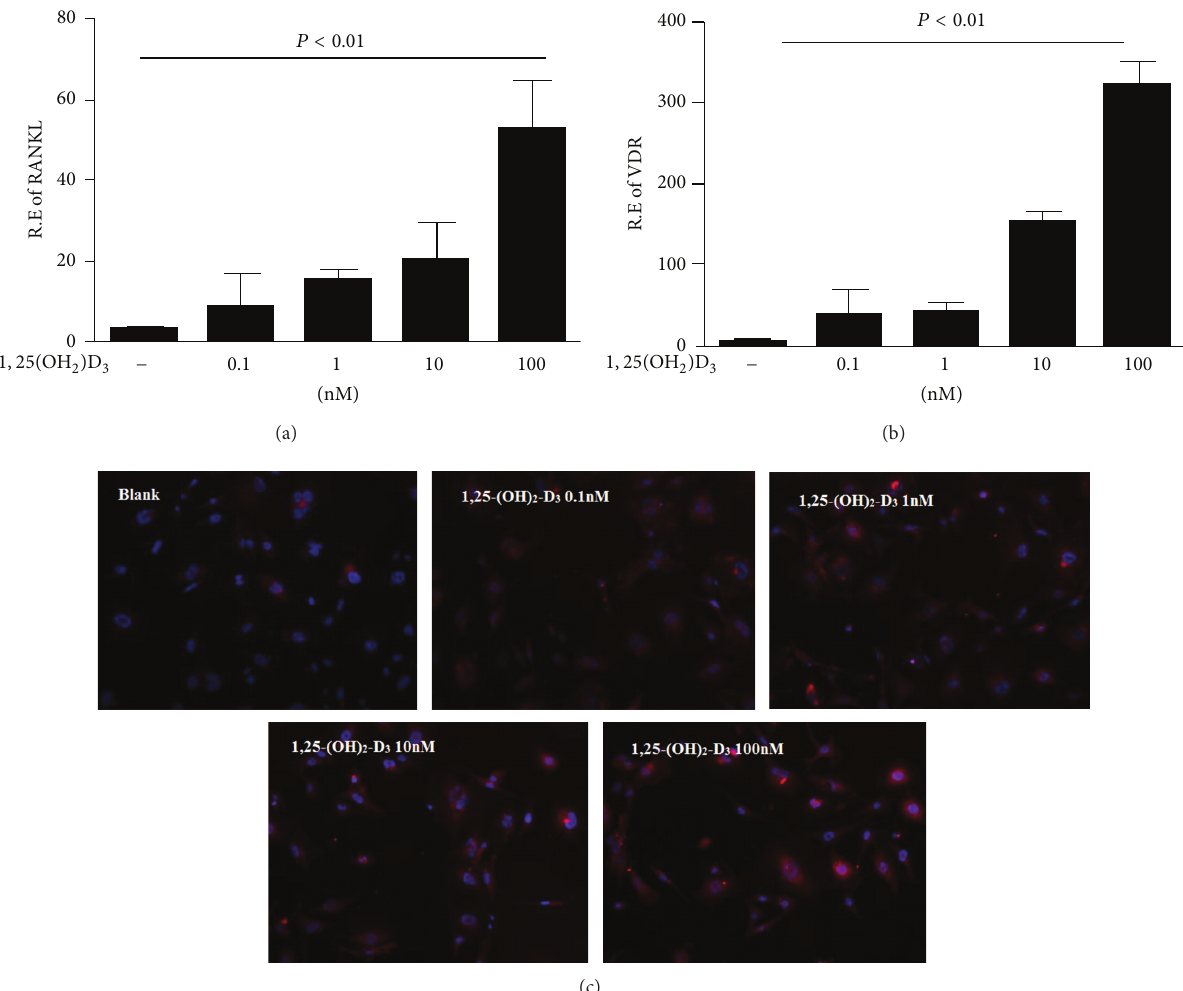
Figure 1: The effect of 1,25(OH) 2 D 3 on RANKL and VDR expression in fibroblast-like synoviocyte MH7A cells. MH7A cells were treated with different concentrations of 1,25(OH) 2 D 3 (0.1nM, 1nM, 10nM, and 100nM) for 48h. RANKL (a) and VDR (b) mRNA expression were analyzed by real-time PCR. The presence of RANKL staining cells (marked with red) in cultured MH7A was detected by immunofluorescence